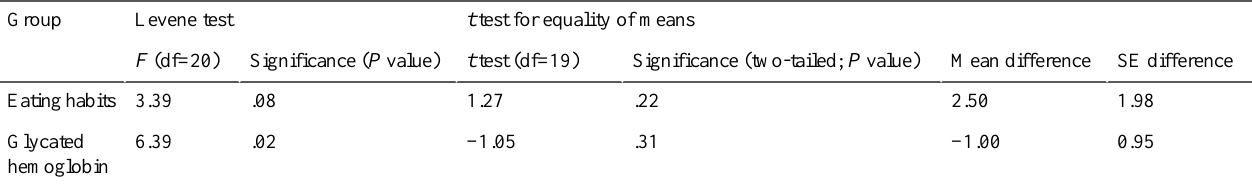
Table 3. Pre-exposure independent t test.